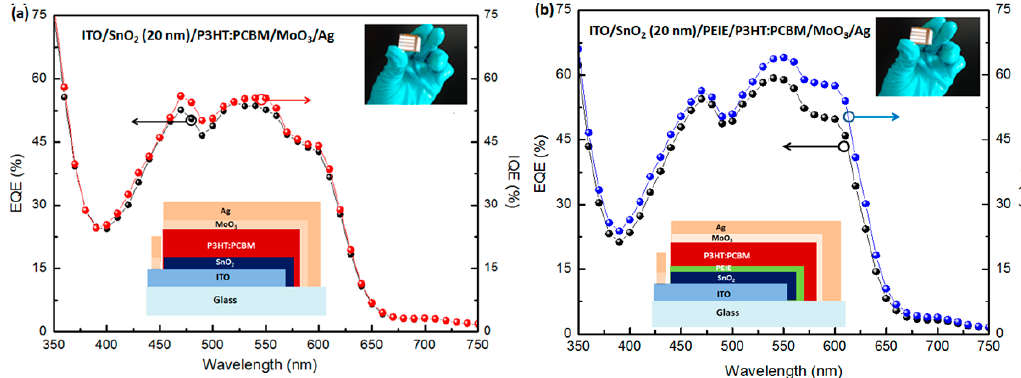
Figure 7. EQE and IQE curve of ( a ) the device with only-SnO 2 (20 nm) and ( b ) best cell based on glass / ITO / SnO 2 20 nm) / PEIE ETL .